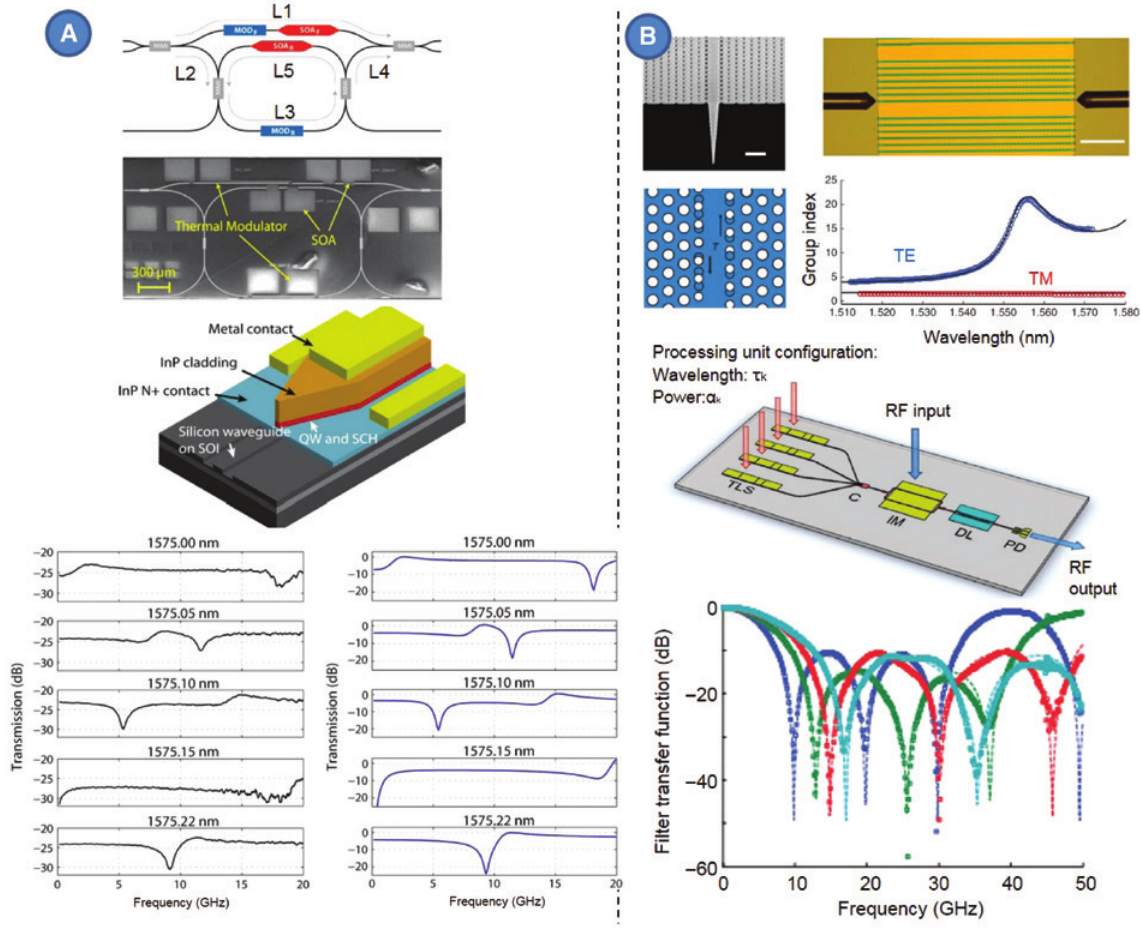
Figure 25: (A) An RF filter implemented using an InP-silicon hybrid circuit [105] (Copyright in 2010, IEEE). (B) An implementation of an RF filter using a photonic crystal waveguide in InP [106] (Copyright in 2012, Nature